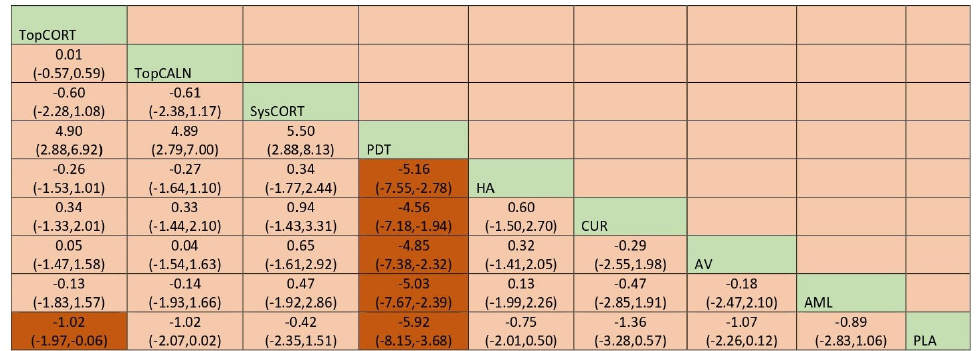
Figure 10. Network Plot: Clinical Score. Abbreviations: AML, amlexanox paste; AV, aloe vera; CUR, curcumin gel; PDT, photodynamic therapy; PLA, placebo; PUR, purslane; SysCORT, systemic corticosteroid; TopCALN, topical calcineurin; TopCORT, topical corticosteroid; HA, hyaluronic acid.